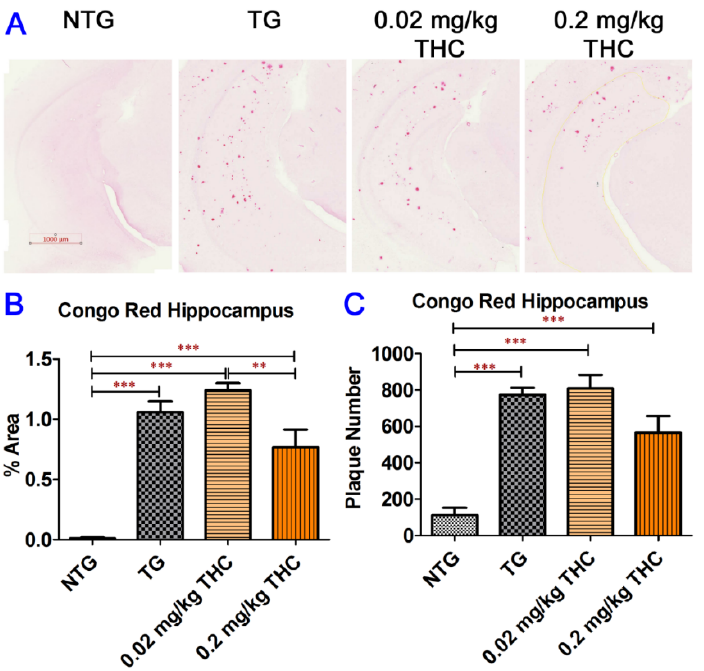
Figure 5. Congo Red staining of A β plaques in mouse hippocampi. ( A ) Representative Congo Red staining images acquired under light microscopy. ( B ) Quantification of Congo red staining shown as the percentage of Congo red-positive area compared to the hippocampus tissue area per field. ( C ) Quantification of Congo red staining shown as the number of Congo red stained plague in the hippocampus area. The non-transgenic (NTG) mice had significantly fewer A β plaques than all the APP/PS1 transgenic (TG) mice regardless of treatment ( p < 0.001 for all). No significant differences in A β plaque area and number of A β plaques were found between the vehicle control and 0.02 or 0.2 mg/kg THC treated APP/PS1 mice. However, the A β plaque area in hippocampi sections of APP/PS1 mice treated with 0.2 mg/kg THC was significantly lower than those treated with 0.02 mg/kg THC ( p < 0.01). Data are expressed as mean ± SD ( N = 7 for the control NTG group, N = 6 for the control TG, and 0.2 mg/kg THC groups, and N = 8 for the 0.02 mg/kg THC group). Error bars denote the SD. ** p < 0.01 and *** p < 0.001 compared between the control NTG mice, control APP/PS1 mice, and APP/PS1 mice treated with 0.02 and 0.2 mg/kg THC using one-way ANOVA followed by the Tukey–Kramer post hoc multiple comparison